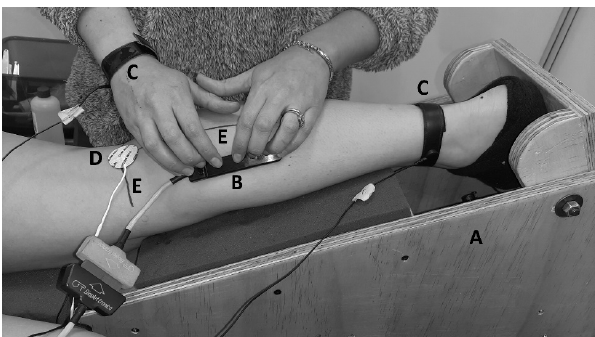
Figure 1. Setup. ( A ) The ankle was fixed with a custom-made modular wood brace so that the ankle joint was kept at 15° of plantarflexion. ( B ) Semi-rigid linear array of 16 electrodes with a silver 5 mm inter-electrode distance. ( C ) Reference for electromyography. ( D ) Cathode for electrostimulation. ( E ) Landmark anatomical frame.